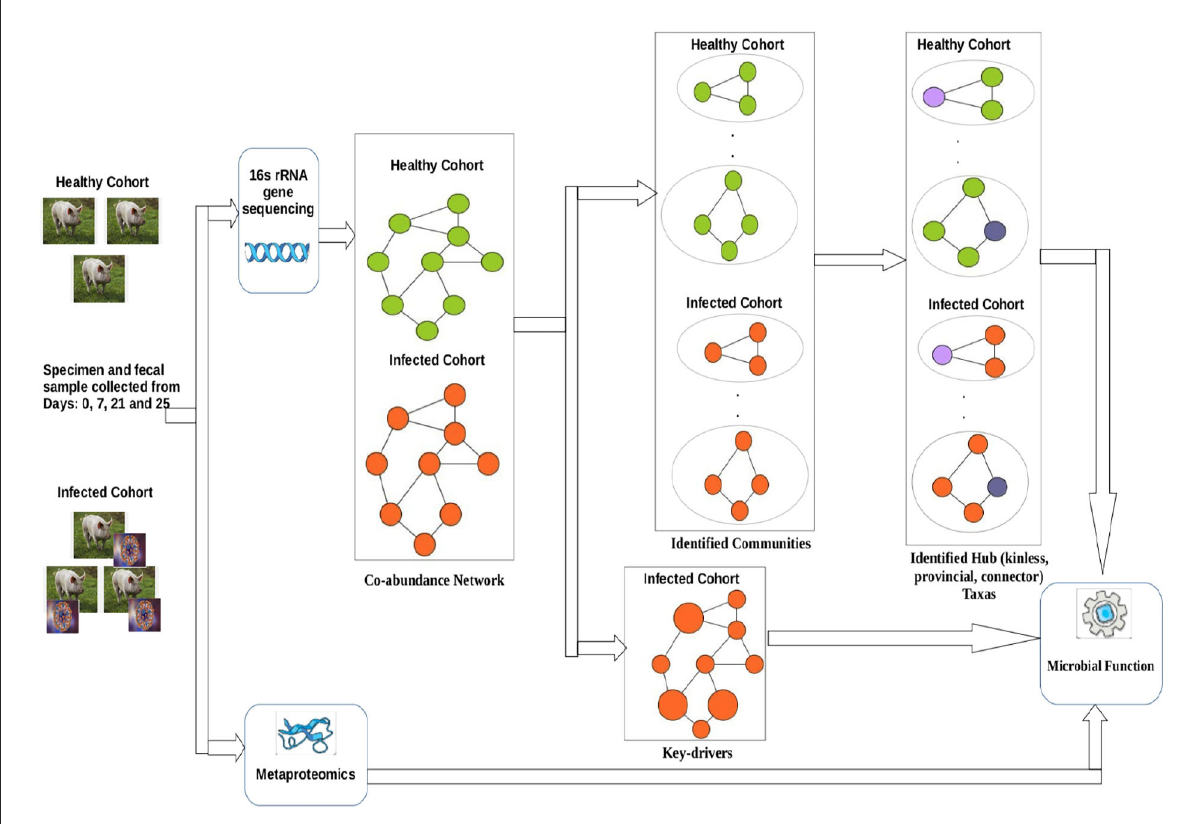
FIGURE1 Workflow used in this